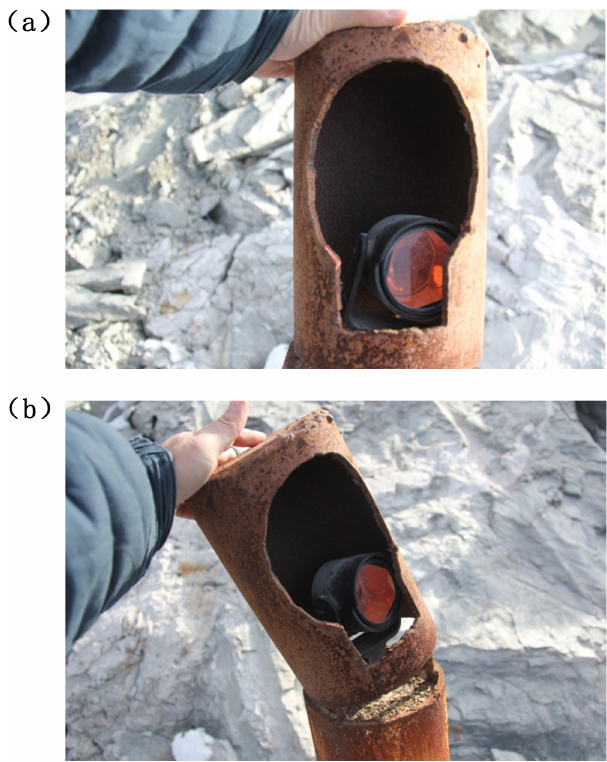
Figure 6. GPS surface displacement monitoring point destroyed by rockfall.